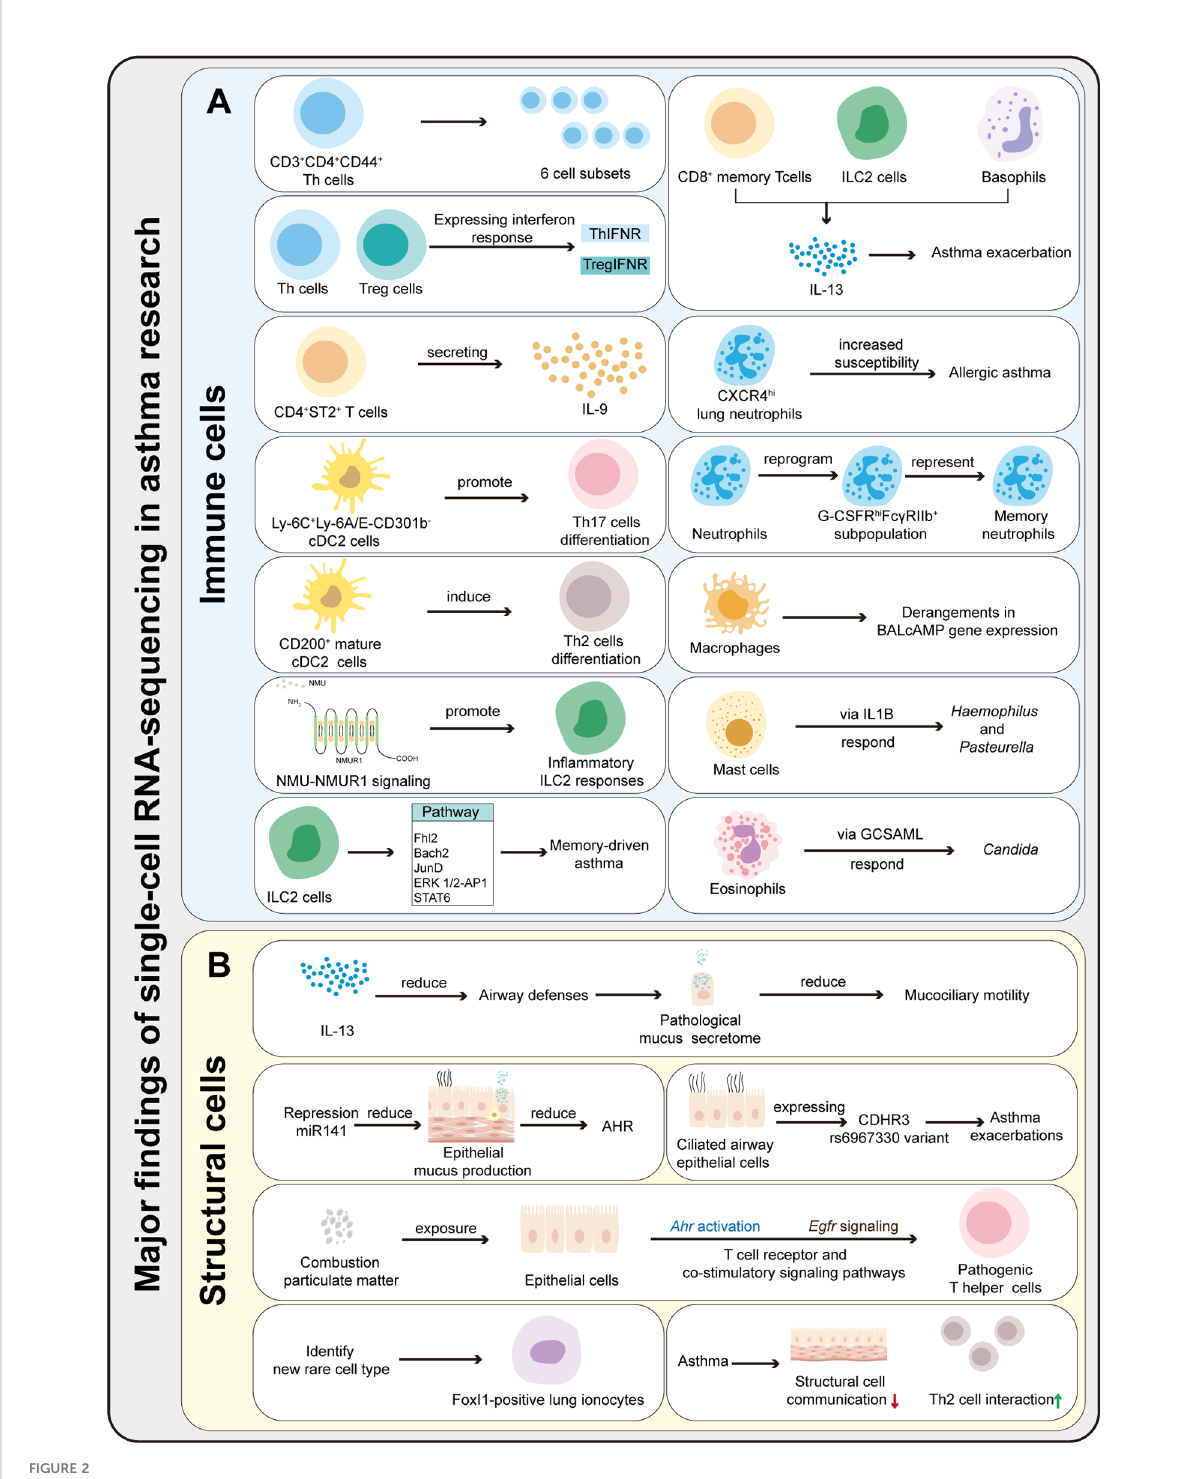
FIGURE 2 Summary of the major fi ndings resulting from scRNA-seq application in asthma research. (A) ScRNA-seq can be used to characterize the heterogeneity and function of immune cells, identify rare cells and new cell subsets, and explores immune cells differentiation mechanisms and pathways in asthma. (B) ScRNA-seq can be used to characterize the function of structural cells, identify rare cells, and explore the communication between immune and structural